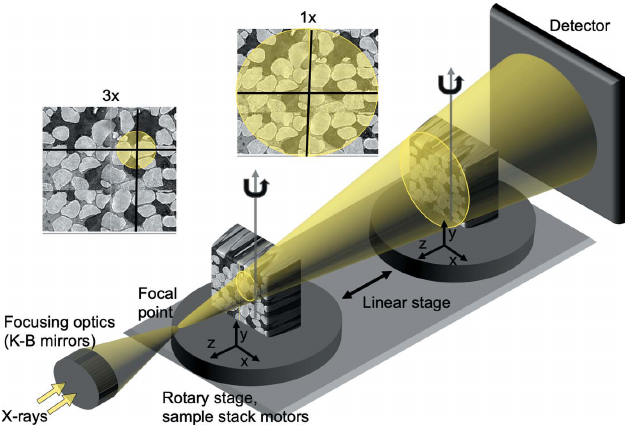
Figure 7 In an X-ray projection microscope the continuous zooming functionality is implemented by moving the sample along the cone beam: magnification is higher if the sample is closer to the focal point, and lower if the sample is closer to the detector.